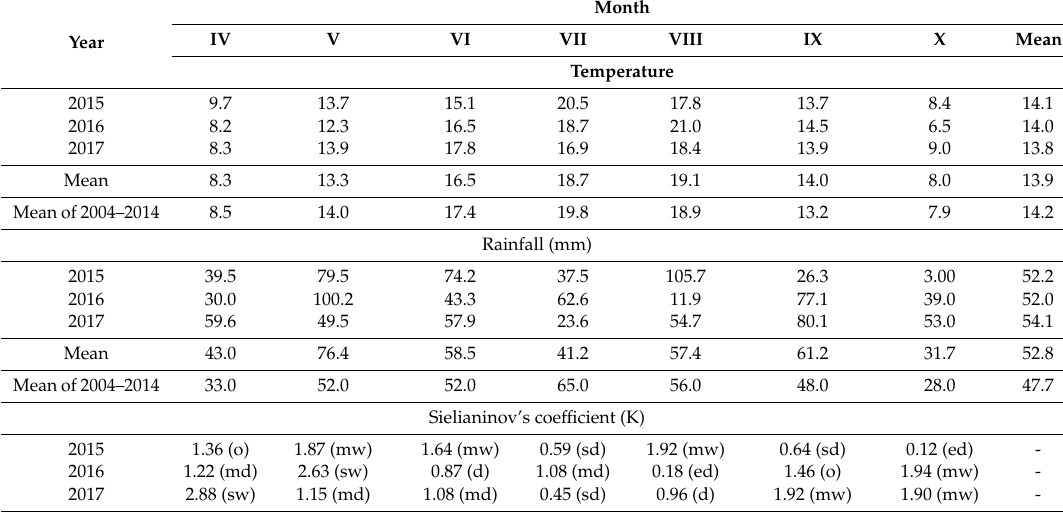
Table 1. Average daily air temperatures per month (OC), monthly rainfall (mm), and monthly Sielianinov’s index.